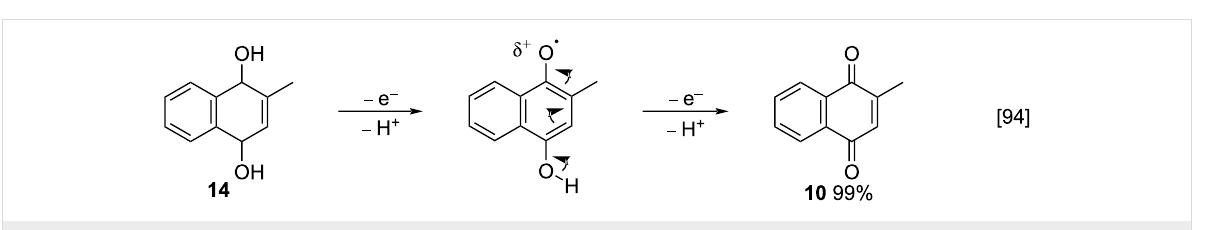
Scheme 10: Representation of electrochemical synthesis of